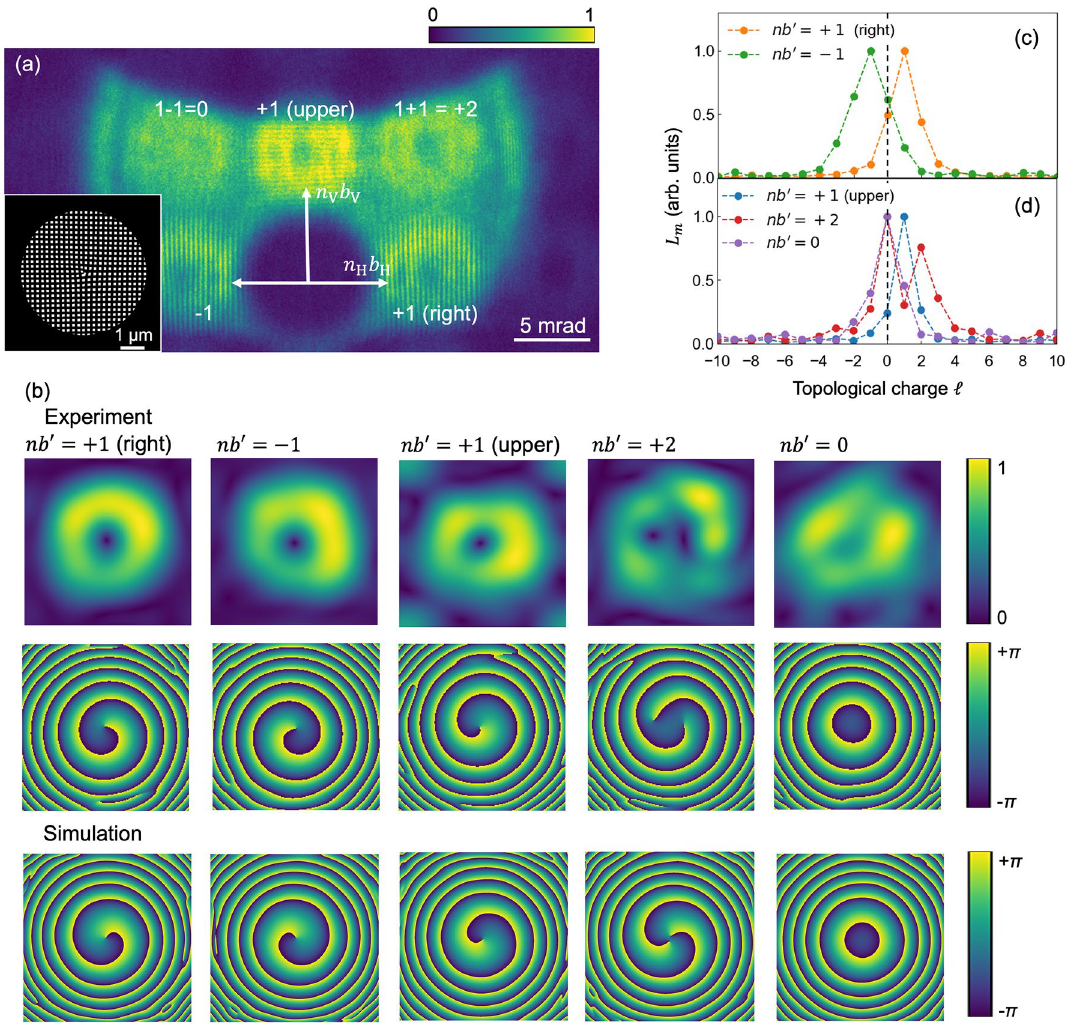
Figure 2. ( a ) Hologram pattern from the fork grating with b H = 1 and b V = 1. The inset shows a schematic of the fork grating. ( b ) A (ρ fn , φ fn ) (first row) and phase distribution (second row) of the vortex diffraction waves for nb ′ = n H b H + n V b V = 0, ± 1 , + 2 . Images in the third row present simulated phase patterns for these vortex diffraction waves. ( c , d ) TC spectrum for each diffraction